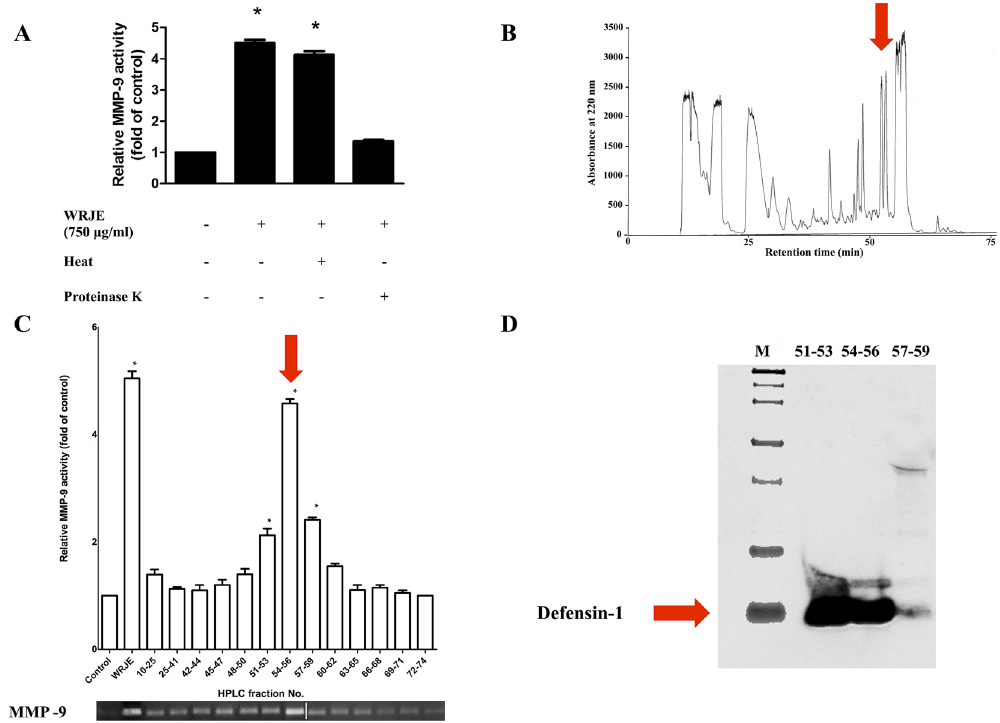
Figure 3. Characterisation and purification of the royal jelly (RJ) component responsible for elevated MMP-9 production. ( A ) Heat and proteinase K treatment was performed by incubation of water royal jelly extract (WRJE) at 100 °C for 5 min and incubation with 150 μ g/ml proteinase K for 1 h at 40 °C followed by heating to 98 °C for 10 min to inactivate the enzyme. Treated WRJE was incubated with HaCaT cells and conditioned equal volumes of the culture media were collected and subjected to gelatine zymography. Densitometric quantification of MMP-9 activity in culture media is presented. ( B ) Heat-treated WRJE was fractionated by a reverse phase-high performance liquid chromatography (RP-HPLC) on a C18 column (250 × 4.6 mm, 5 μ m) at a flow rate 0.3 ml/min, with elution using a 10–90% gradient of acetonitrile (containing 0.1% (v/v) trifluoroacetic acid) for 85 min. ( C ) The HPLC fractions were assayed for MMP-9 induction. ( D ) HPLC fractions with maximal MMP-9 activity (51 to 59 min) were used for identification of MMP-9 inducer and were subjected to 16.5% Tricine-SDS-PAGE gels. Defensin-1 (5.5 kDa) was detected by Western blotting using a rabbit polyclonal anti-honeybee defensin-1 antibody diluted 1:2000 in blocking buffer. Horseradish peroxidise-conjugated secondary antibodies were applied. (The gels/blots with indicated cropping lines are shown in Supplementary Fig. S3). White line in gel indicates the place where two gels were spliced together. Data are expressed as means and SEMs of three independent measurements. Asterisks indicate a significant difference from the untreated group, * P <